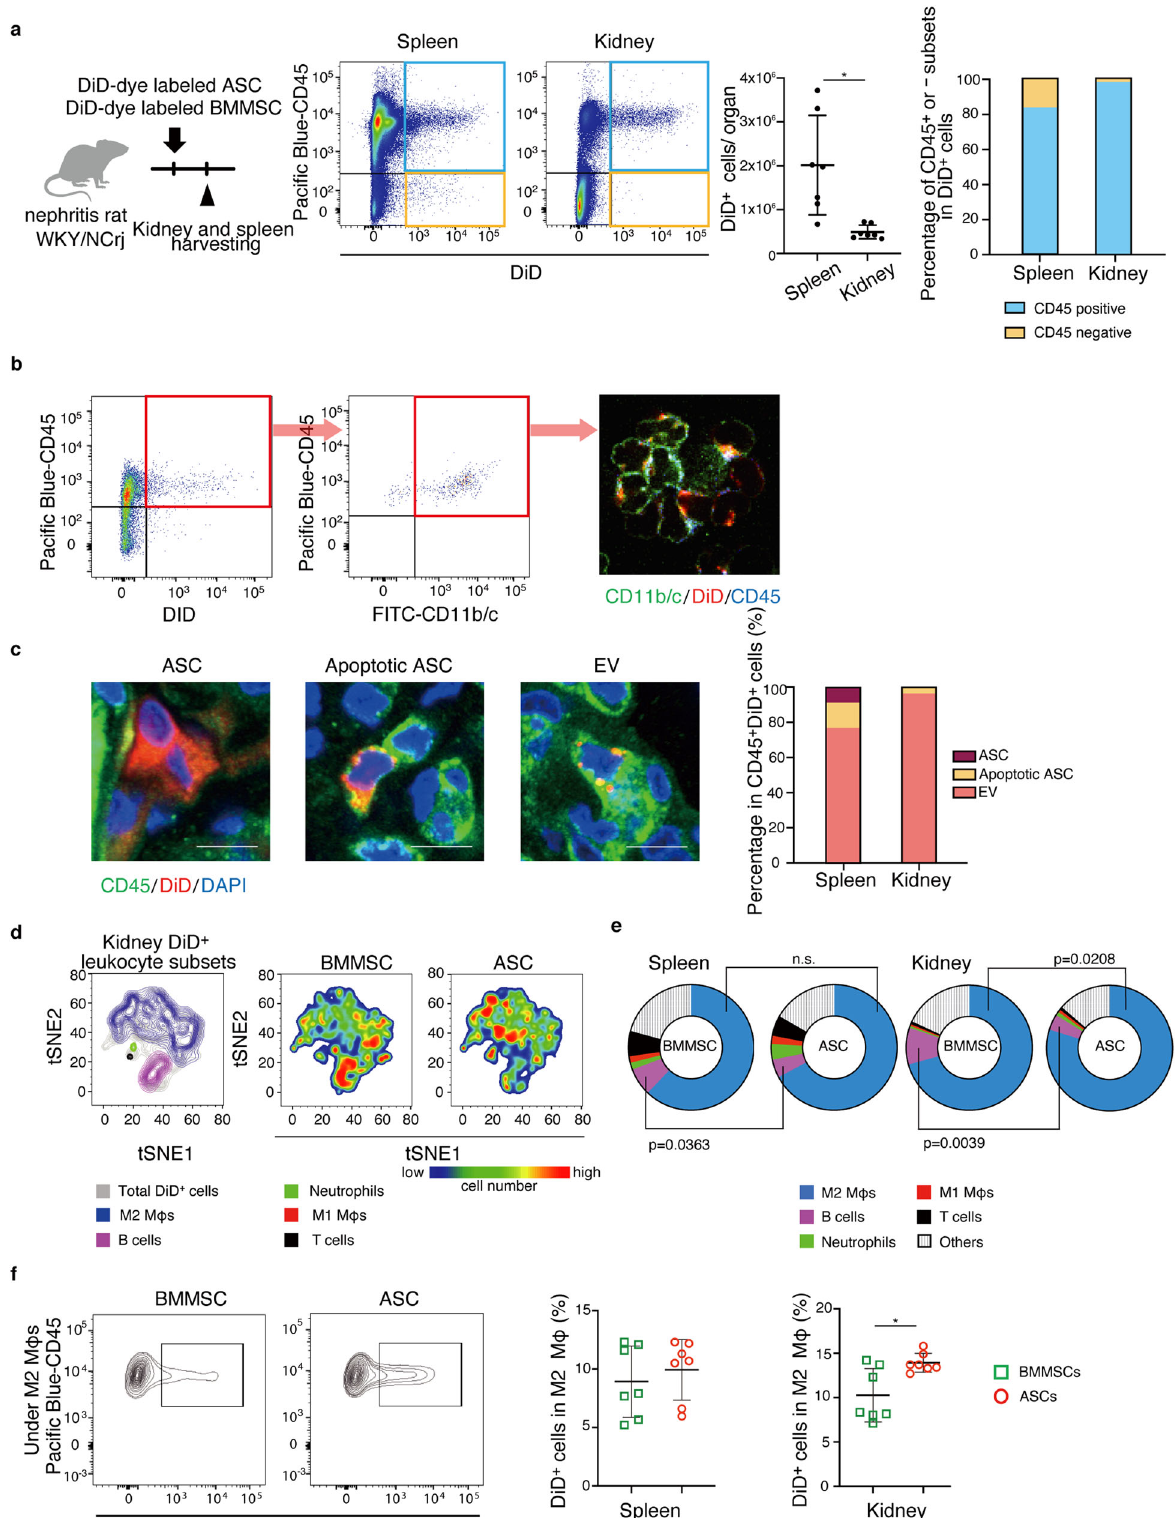
Then, we observed the dynamics of EV-positive leukocytes in the spleen (Fig. 7g and Supplementary movie S2). We found that the splenic leukocytes, into which ASC-derived EVs were transferred, moved into the blood vessels and circulated through the blood- stream. We observed that ASCs increased M2 macrophages in the kidney on day 3 (Fig. 2c), while they slightly increased the ratio